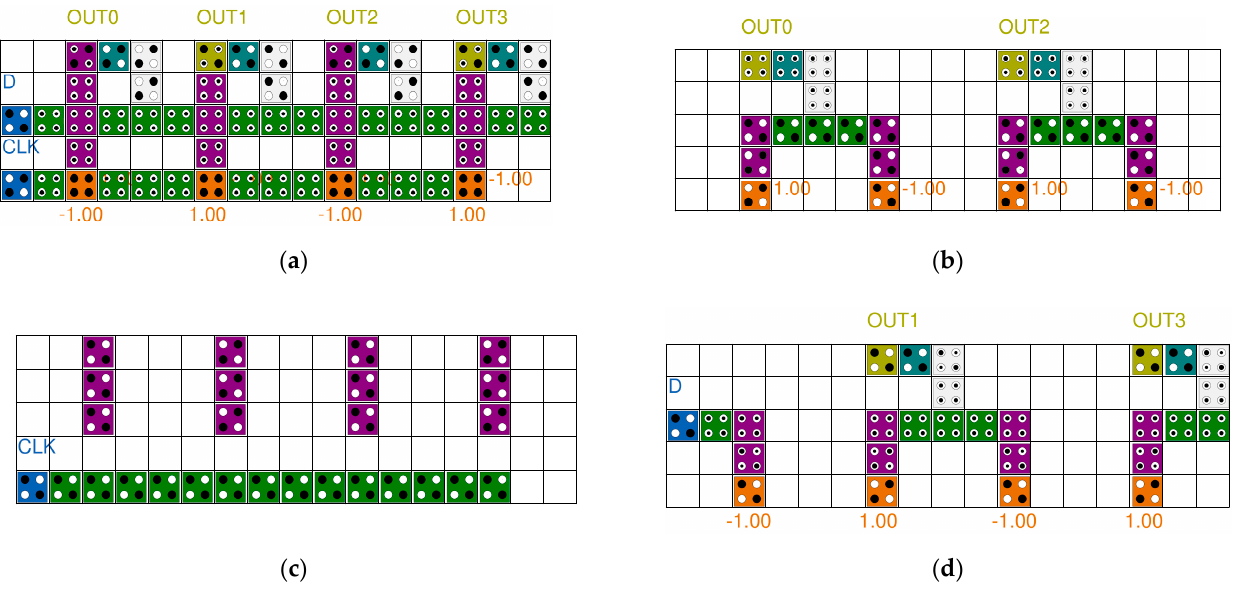
Figure 12. Proposed 4-bit SR: ( a ) Top view; ( b ) layer 1; ( c ) layer 2; and ( d ) layer3.